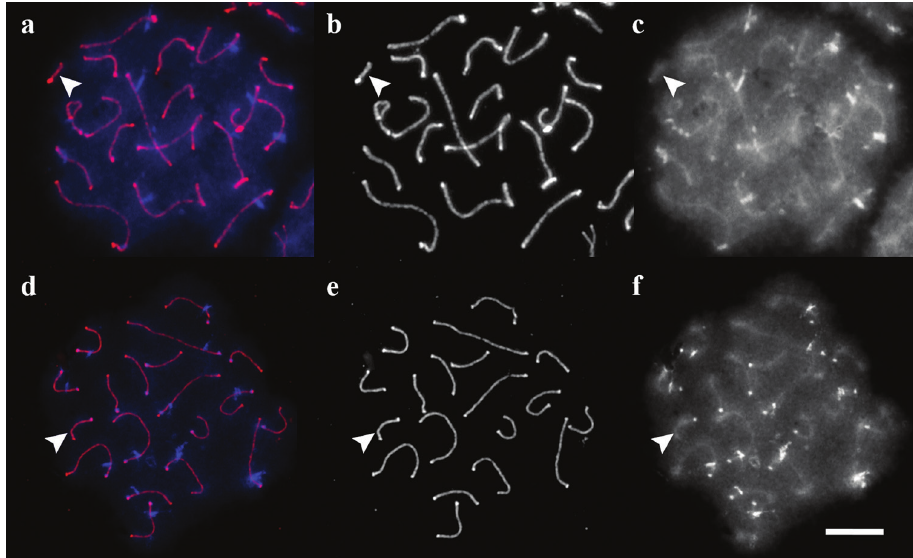
Figure 5. SC spreads of the sand lizards after C-like DAPI staining. a–c standard homozygote d–f ho- mozygote for the long variant of chromosome 19 a, d merged images b,e SYCP3 c, f DAPI. Arrowheads show SC 19. Scale bar: 10